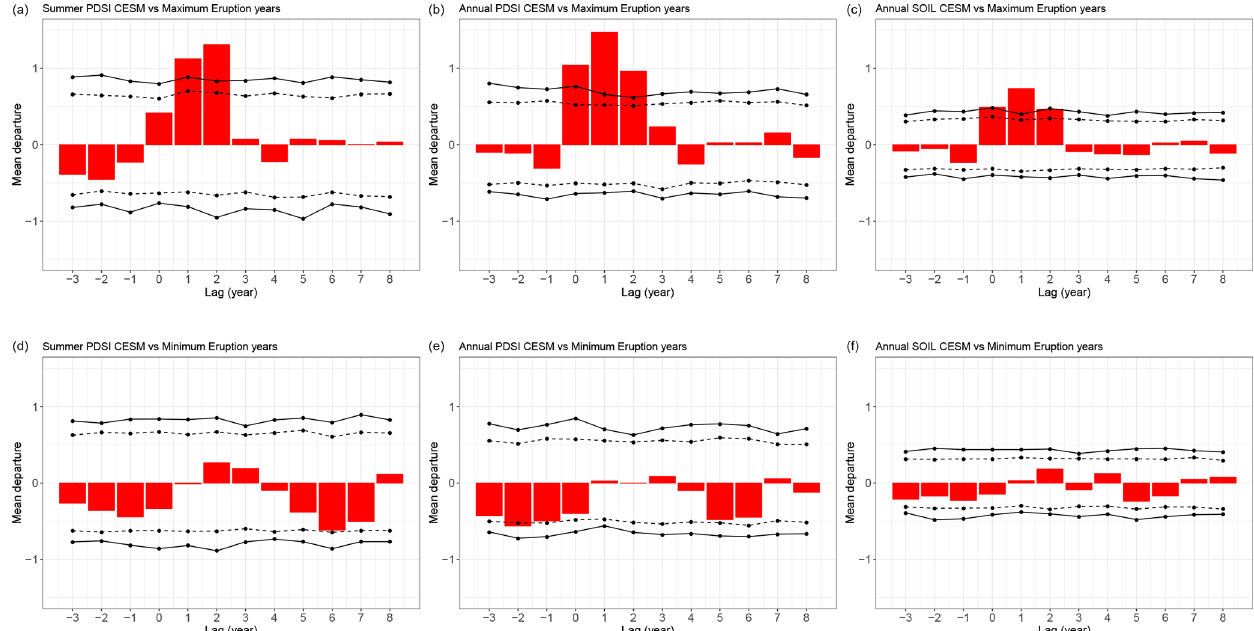
Figure 7. Superposed epoch analysis between the yearly drought indices in CESM (summer scPDSI, annual scPDSI, and SOIL) and years of eruptions for (a–c) the 16 largest eruptions and (d–f) the 16 smallest eruptions. The upward-pointing bars indicate the positive changes and downward-pointing bars show the negative changes before and after the eruptions. Continuous lines indicate the 99% confidence interval and dashed lines the 95% confidence interval from the bootstrap resampling of the time series. The list of the eruptions used for the analysis is in Table A2.